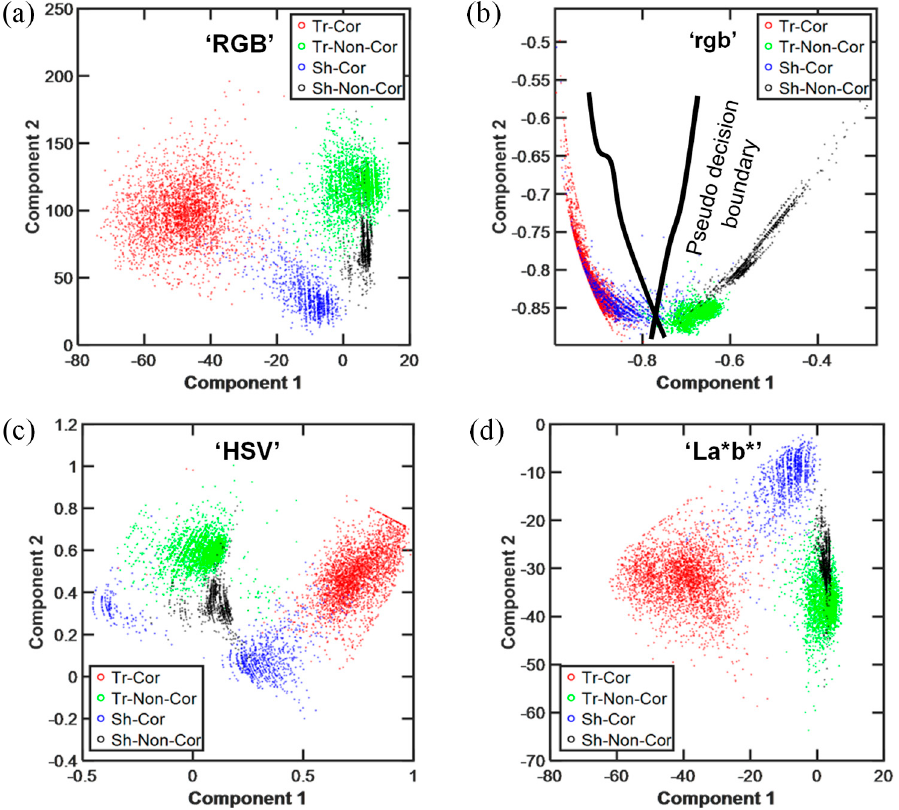
Figure 6. Dimensional reduction using LDA. Training dataset encompassing 4 class labels namely corrosion (Tr-Cor), non-corrosion (Tr-Non-Cor), corrosion in shadow (Sh-Cor) and non-corrosion (Sh-Non-Cor) in shadow are visualized in a 2-dimensional space. ( a ) RGB, ( b ) rgb, ( c ) HSV and ( d ) La*b*.